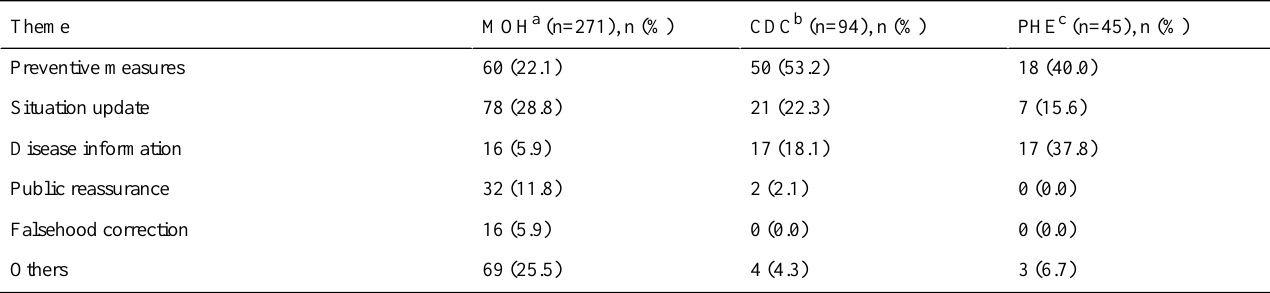
Table 3. Thematic analysis of the public health authorities’coronavirus disease outreach